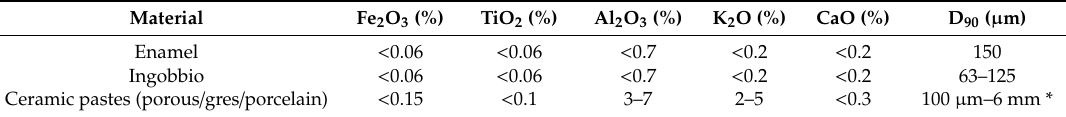
Table 2. Quartz sand specifications.